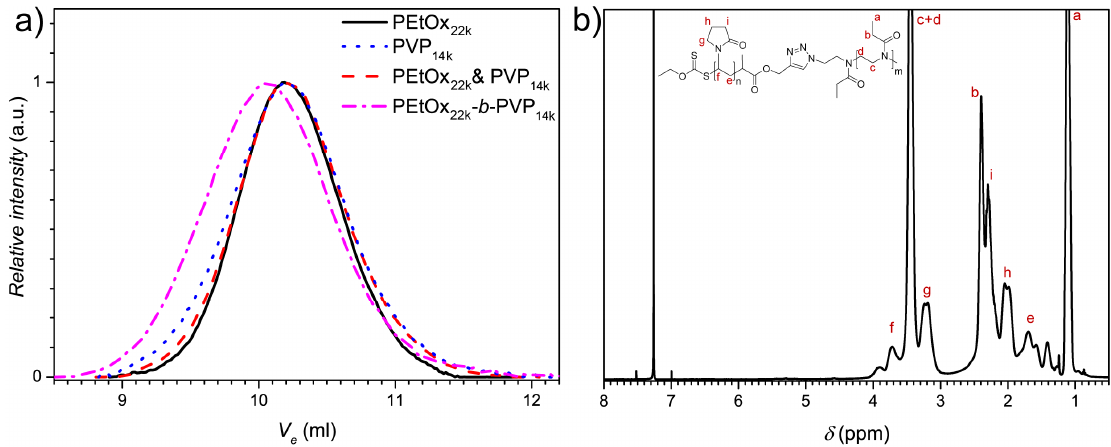
Figure 1. ( a ) SEC traces of PVP 14k , PEtOx 22k and PEtOx 22k - b -PVP 14k block copolymer recorded in acetate buffer with 20% MeOH and ( b ) 1 H-NMR spectrum of PEtOx 22k - b -PVP 14k recorded at 400 MHz in CDCl 3 .